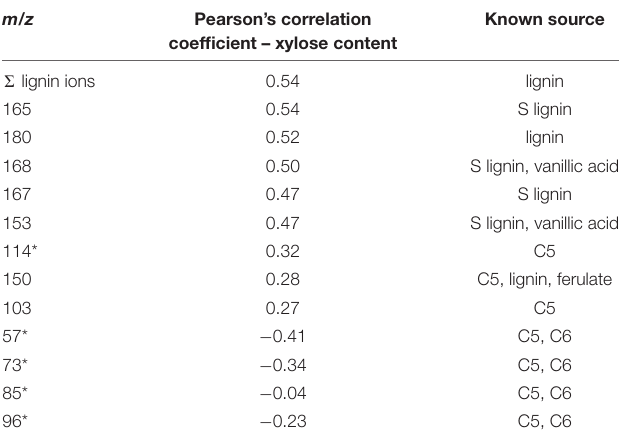
TABLE 2 | PCCs for selected ions as they relate to xylose content in P. trichocarpa natural variant biomass samples. m/z Pearson’s correlation coefficient – xylose content